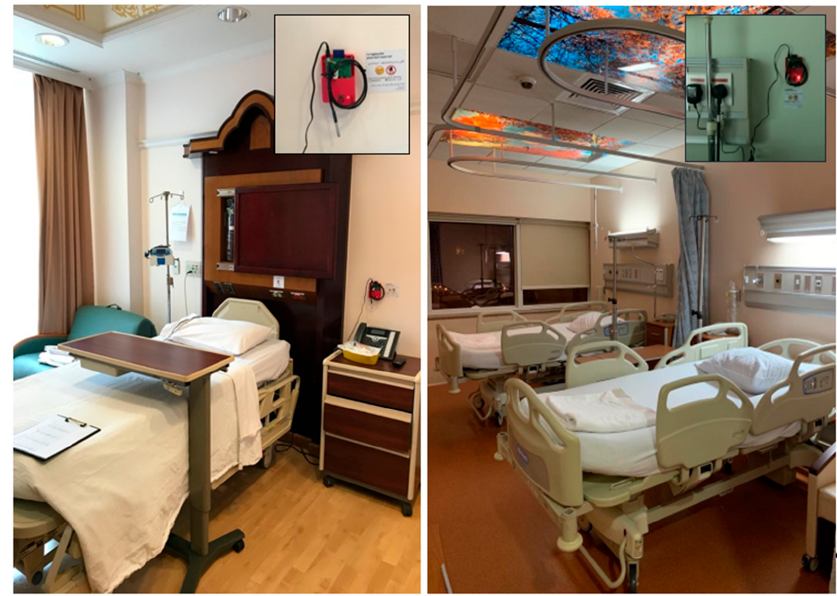
Figure 3. Raspberry Pi +3 mounted in patient rooms in IMC ( left ) and KAMC ( right ).